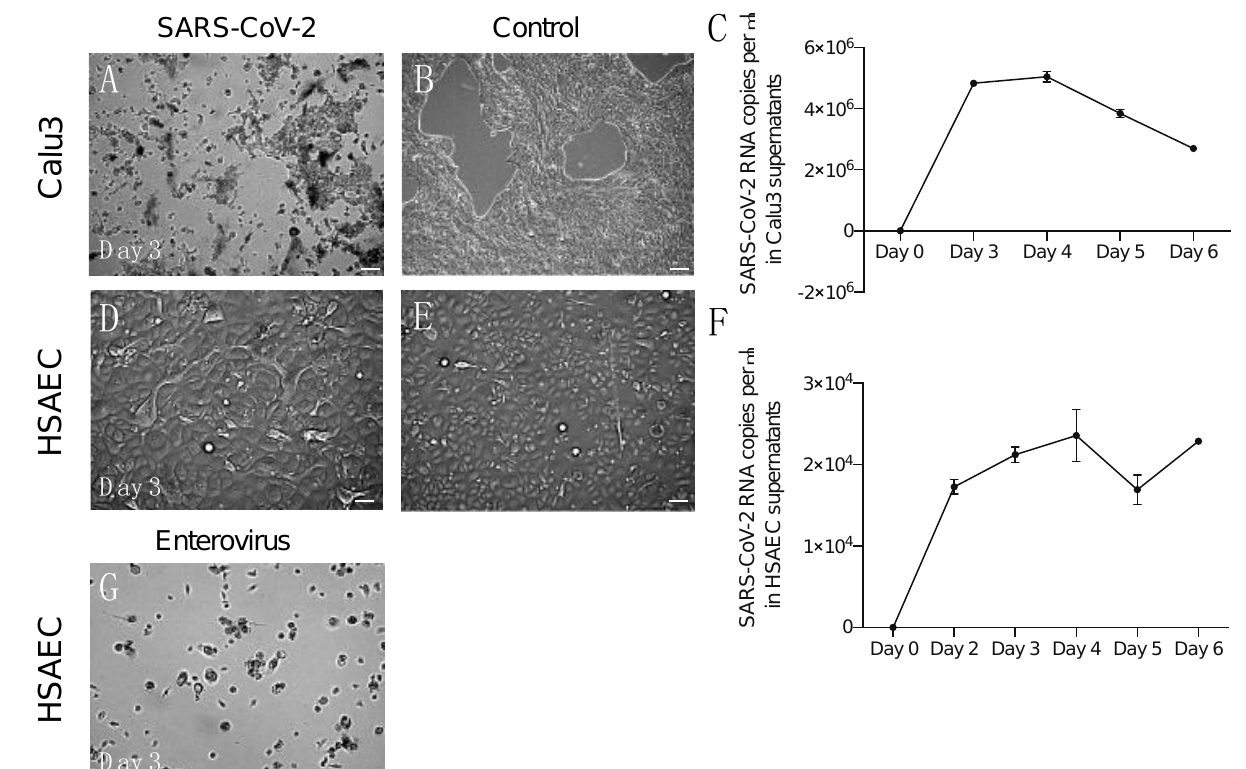
Figure 1. Virus replication in vitro in Calu 3 cells and HSAEC. ( A ) CPE observed in infected Calu3 cells on day three post-infection. ( B ) Morphology of uninfected Calu3 cells. ( C ) Viral RNA copy number measurements performed in duplicate in Calu3 cell supernatants. ( D ) Morphology of HSAEC on day three post-infection; no CPE observed. ( E ) Morphology of uninfected HSEAC. ( F ) Viral RNA copy number measurements performed in duplicate in HSAEC supernatants. ( G ) HSAEC infected with enterovirus; CPE observed at day three post-infection. Scale bars 100 µ m. Larifan showed unapparent cytotoxicity in Calu3 and HSAEC cell lines at all the concentrations used in this study. The half-maximal cytotoxic concentrations of Larifan in Calu3 cells and HSAEC were 985.95 µ g/mL and 3962.18 µ g/mL, respectively (Figure 2A). As expected, SARS-CoV-2 infection caused a very high increase in virus RNA copy numbers and infectious virus titer in both cell lines under investigation. This is in line with others’ observations, who also noticed an abundant presence of the virus in common cell culture models [19,20]. Despite the high virus presence, Larifan in both cell lines inhibited the replication of SARS-CoV-2. Viral RNA copy numbers in the supernatant of Calu3 cells dropped from 9.6 × 10 6 to an average of 1.4 × 10 6 ( p = 0.0296) when Larifan was present. Out of the three conditions analyzed, the virus RNA copy number dropped significantly if Larifan was added pre- ( p = 0.018) and post-infection ( p = 0.0054). In contrast, no significant drop could be observed in the case of full-time treatment ( p = 0.6204) (Figure 2B). The titer of the infectious 7.0log 10 virus measured in Vero E6 cells also dropped significantly in Calu3 cell supernatant to an average of 4.5log 10 ( p = 0.0286) when Larifan was present. Furthermore, there was a significant decrease in the virus titer when Larifan was added before infection ( p = 0.0014) (Figure 2C). A reduction in viral RNA copy number was also observed in HSAEC (Figure 2D), especially when Larifan was added before infection ( p = 0.0218) with a drop from 4.1 × 10 5 to 2.3 × 10 4 accompanied by a decrease in virus presence in the cells assessed by immunofluorescence of SARS-CoV-2 nucleoprotein (NP) (Figure